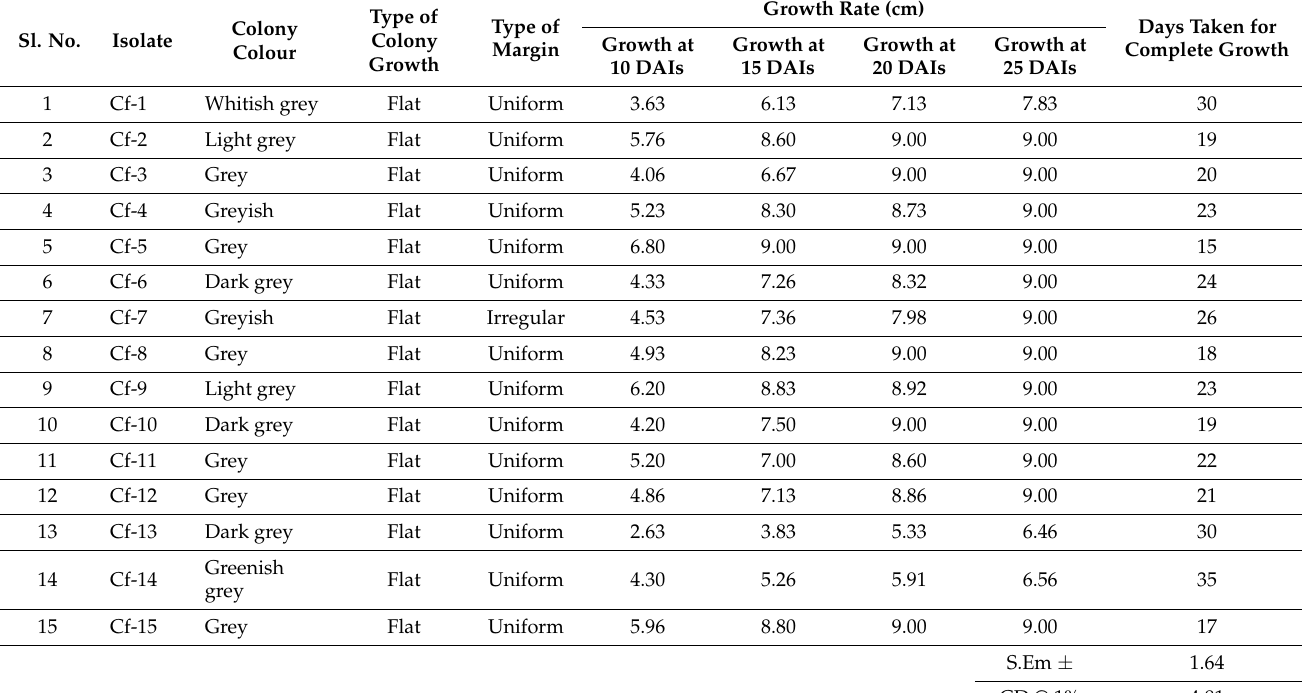
Table 2. Cultural characteristics of different isolates of Ceratocystis fimbriata on potato dextrose